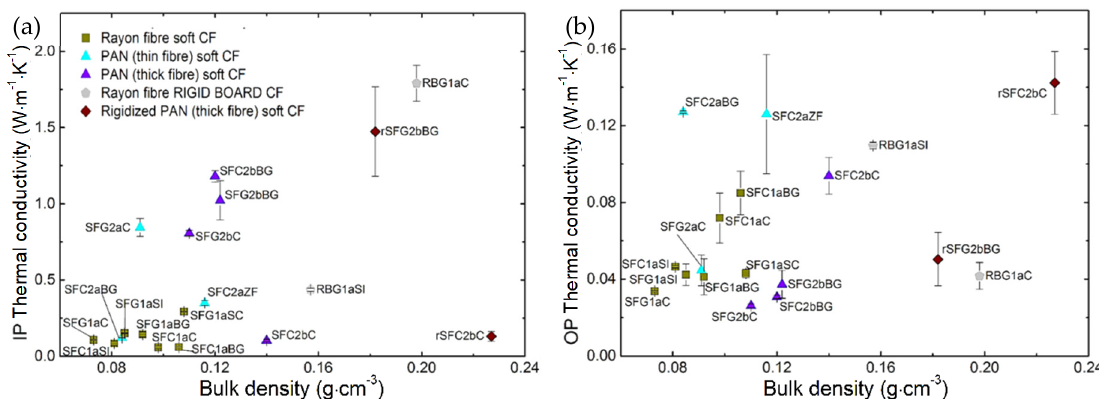
Figure 12. Thermal conductivity of all materials in: ( a ) IP direction and ( b ) OP direction, as a function of bulk density. The symbols in (b) have the same meaning as in (a).